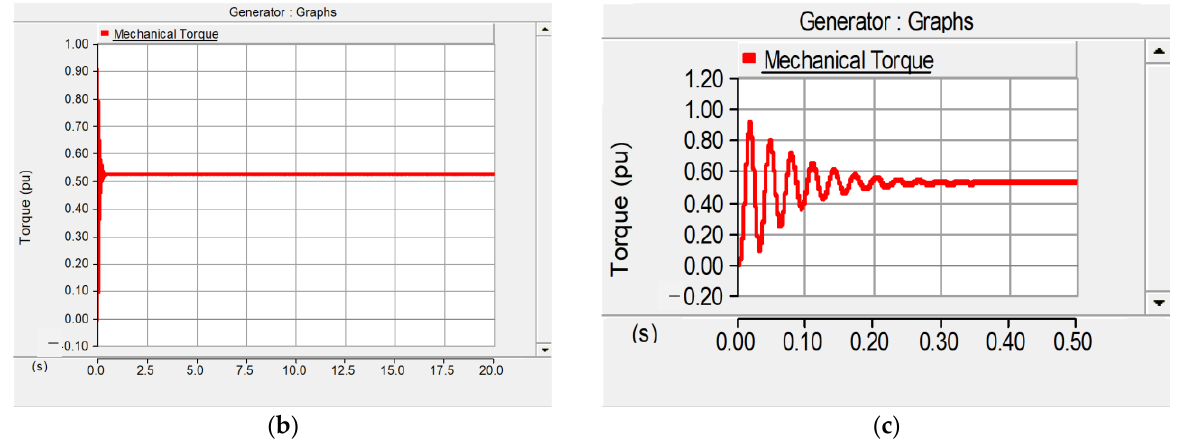
Figure 30. ( a ) Speed; ( b ) entire system torque output; ( c ) torque fluctuations at starting during constant speed. Figure 31a,b show the DC and terminal voltages graphs, respectively. The system DC voltage decreases in this low-speed case. The magnitude of the terminal voltage decreases sharply after 1.5 s due to the reduced speed and torque change. In this case, the magnitudes of the voltage decreased more with the decrease in the speed as compared with the first case.